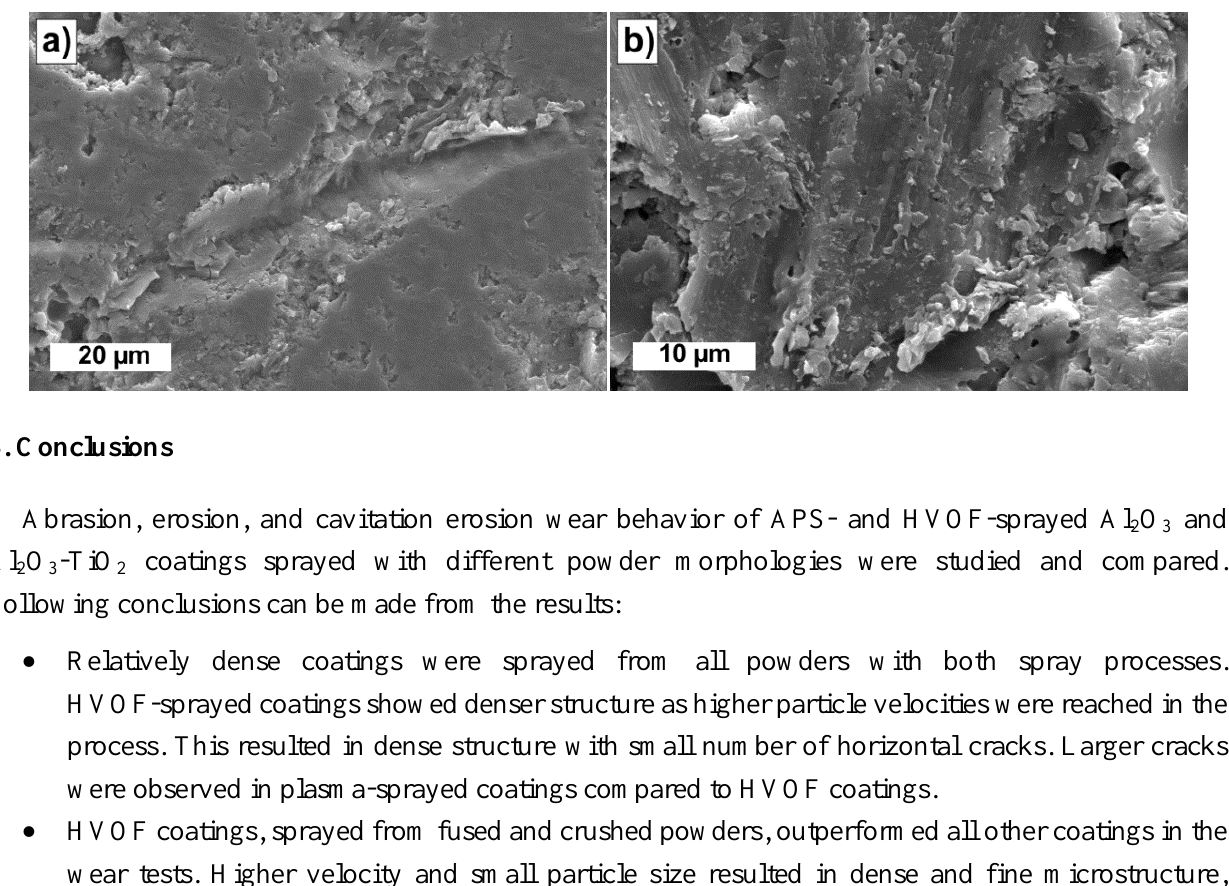
Figure 14. Worn surfaces of ( a ) HVOF_AT2 and ( b ) APS_AT2 coatings after the erosion